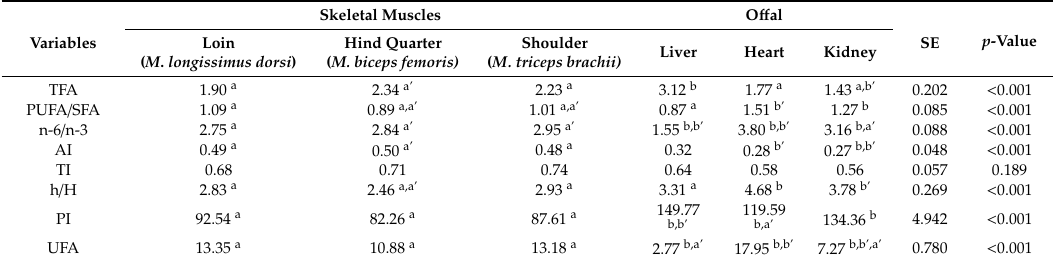
Table 4. Total trans fatty acids and fatty acid ratios and lipid quality indices in lipids from di ff erent red deer tissues.